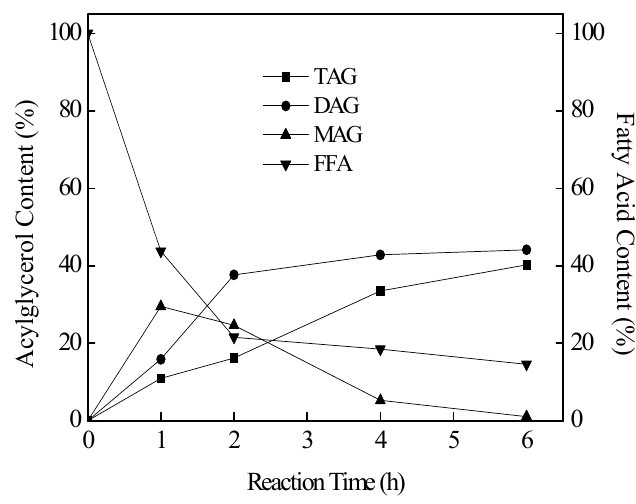
Figure 1. Novo 435 catalyzed esterification of CLA and glycerol. Reaction conditions were as follows: CLA/glycerol molar ratio, 3:1; enzyme loading, 1% (w/w, with respect to